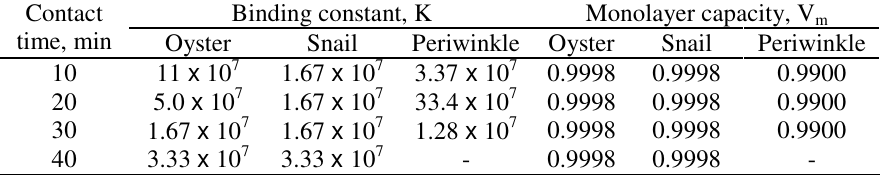
Figure 4 . Curve fitting for adsorption of lead ion by snail, oyster(oyst) and pererwinkle (perew) shell according to Lagmuir adsorption Table 1. Values of Langmuir parameters for adsorption of Pb 2+ on oyster, snail and periwinkle shells.